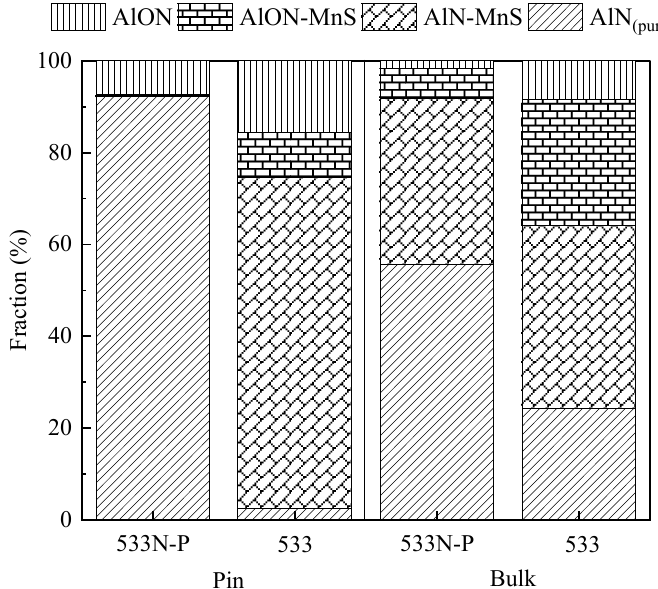
Figure 6. The fraction of AlN subclasses in the pin and bulk samples of 533N-P and 533 steel melts.